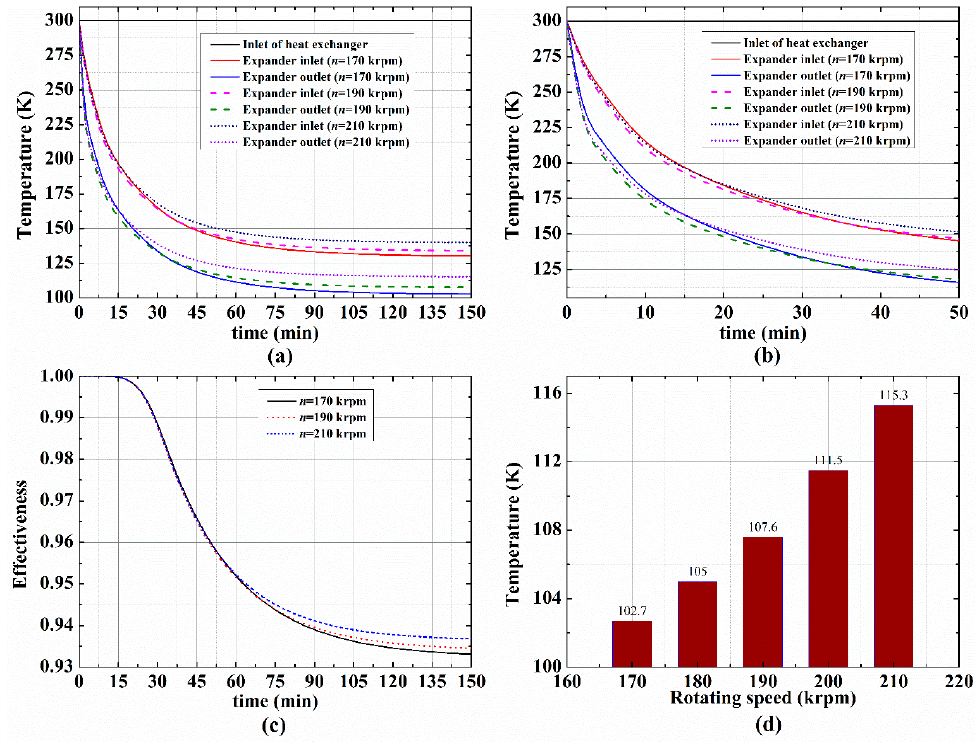
Figure 8. Dynamic cooling characteristics with a motor: ( a ) Refrigerator cooling characteristics; ( b ) cooling characteristics at the beginning; ( c ) effectiveness of the heat exchanger; ( d ) ultimate refrigerating temperature.